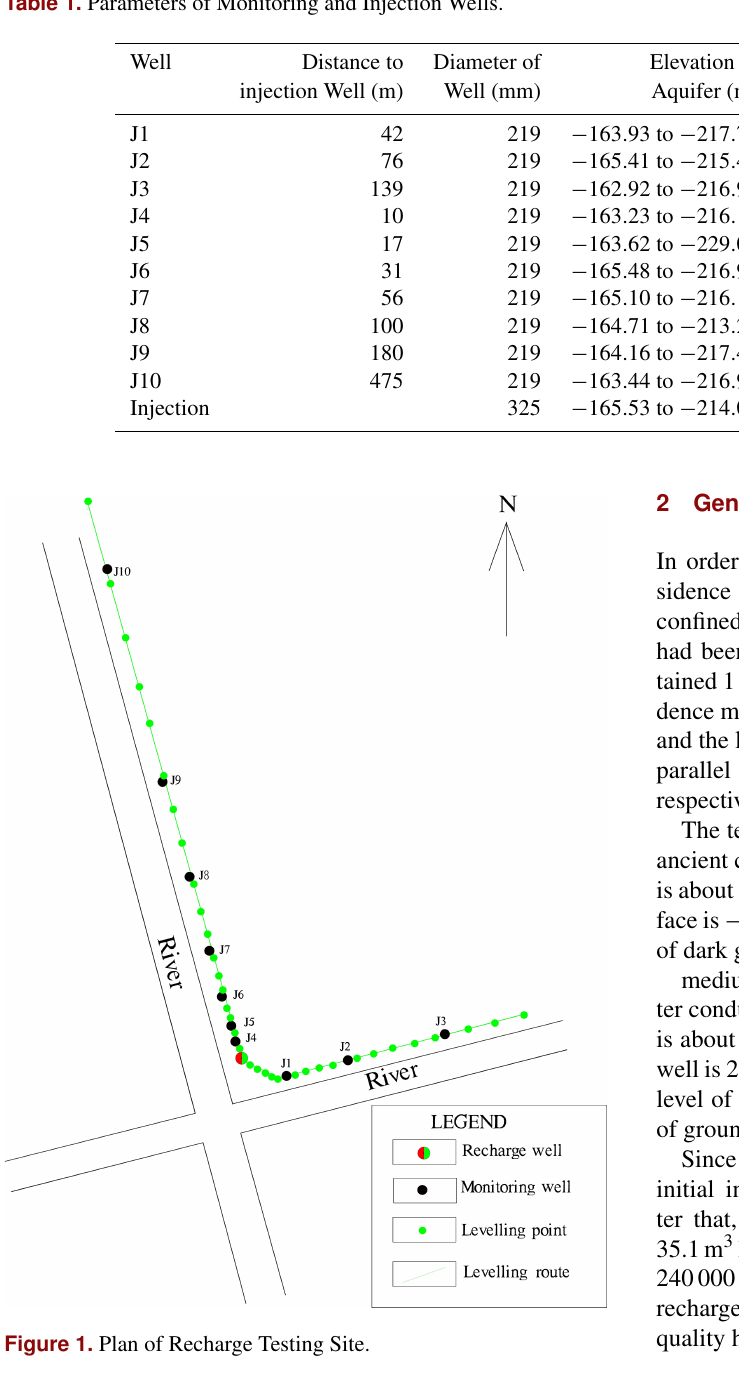
sand layer. At the same time, the upper clay layer is filled with a lot of water, the pore water level rises, and the cohesive soil expands. The superposition of the rebound of sand layer and the expansion of cohesive soil results in the rebound of the